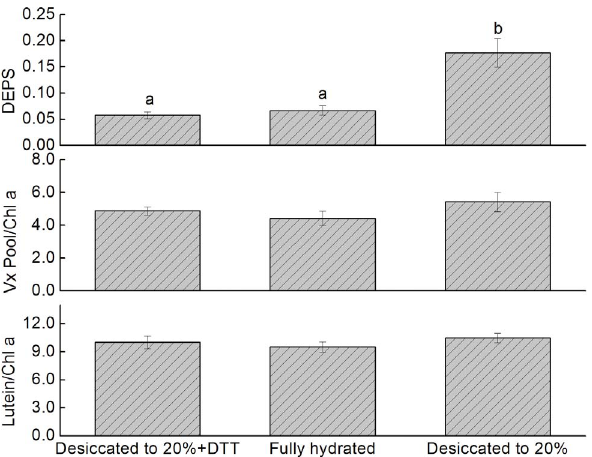
Figure 5. Effects of dithiothreitol (DTT) on the Xc and lutein content of U.pertusa thalli during desiccation in air under dim light. DTT was infiltrated into thalli before desiccation treatment. Experimental conditions were as in Fig. 2. Error bars represent SD for n=3.